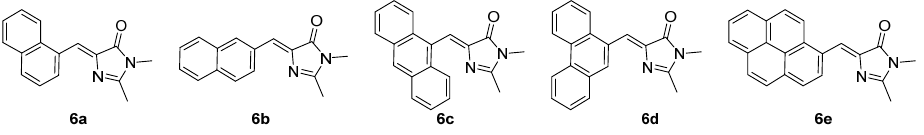
Figure 6. GFPc analogues with large aromatic substituents [20].